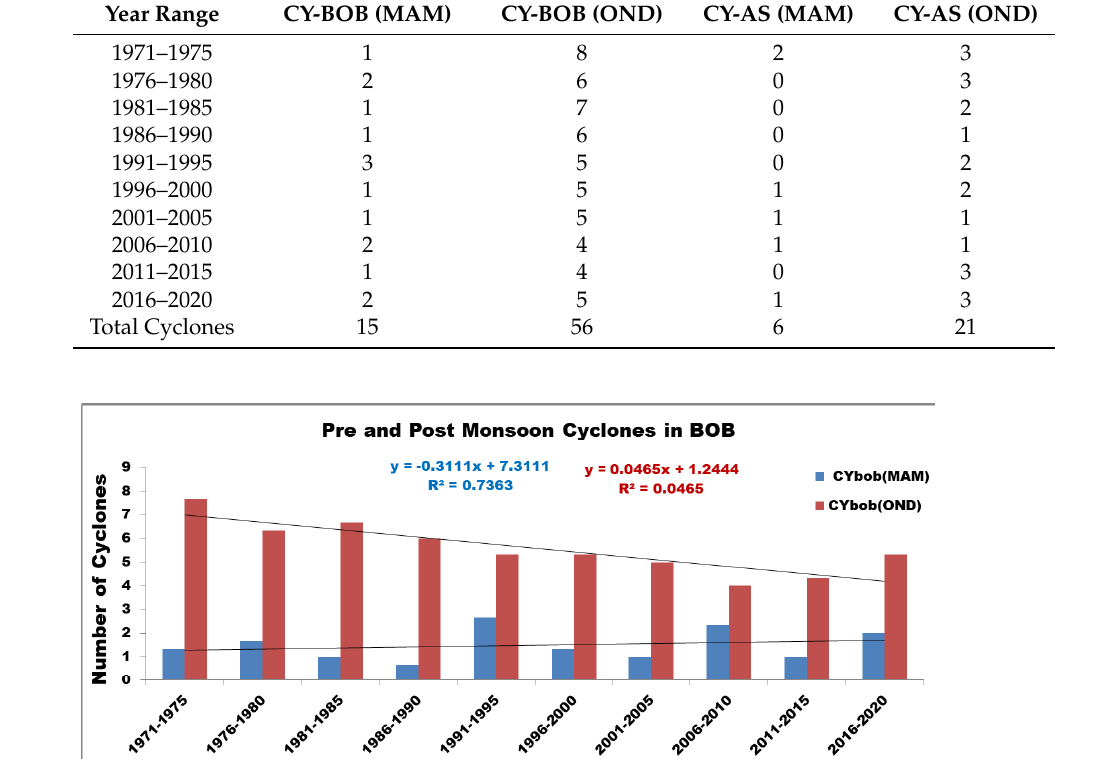
Figure 6. Scatter plots between standardized SST anomalies and number of cyclones (CY) for the neutral IOD years for BOB − MAM, AS − MAM, BOB − OND and AS − OND. Table 1. Number of cyclones from 1971–2020 at intervals of 5 years.